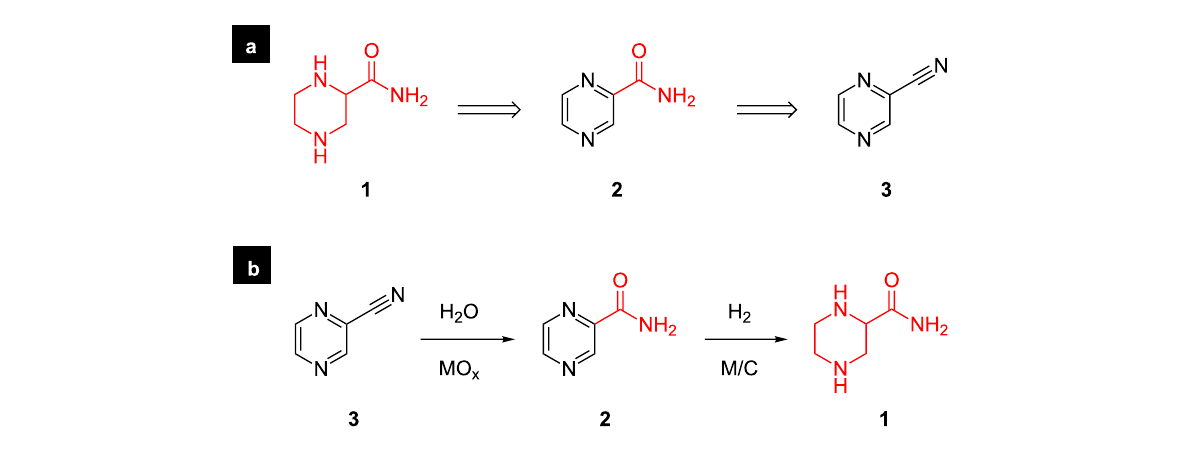
Figure 2: Two step approach to piperazine-2-carboxamide via hydrolysis followed by reduction. (a) Retrosynthesis and (b) catalytic transformations.